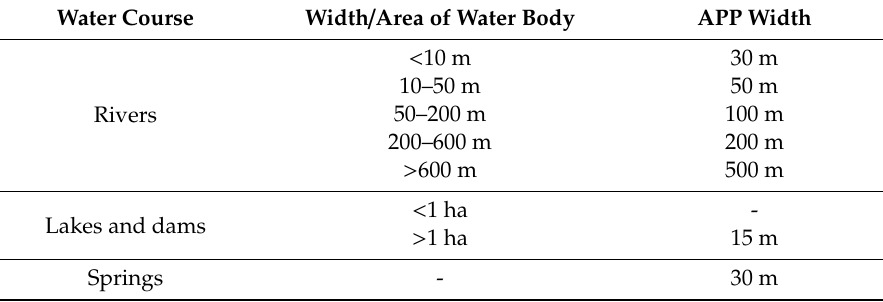
Table 2. Permanent preservation area (APP) widths based on the water course widths, under Brazilian environmental law (Law no. 12651, 25 March